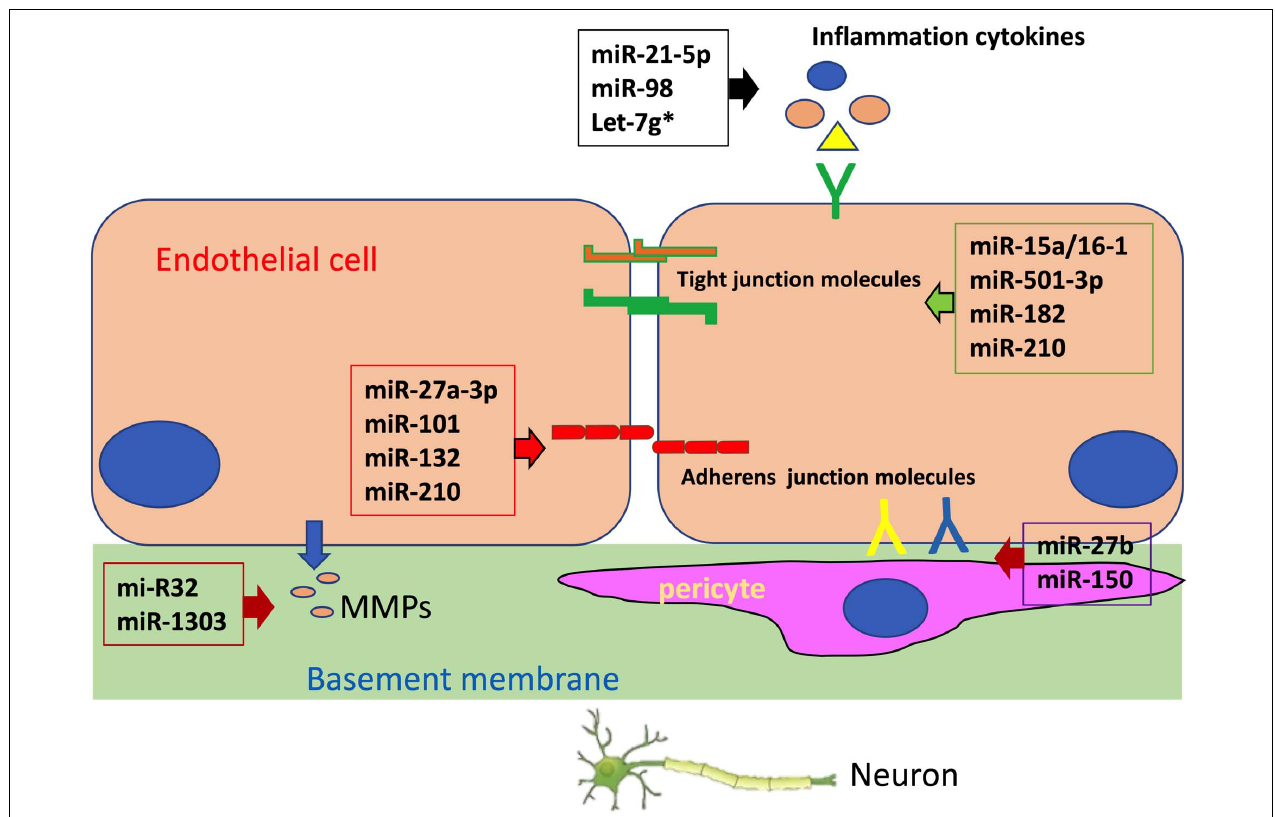
FIGURE 1 | MicroRNAs (miRNAs) regulate blood–brain barrier (BBB) integrity by targeting endothelial tight junction, basement membrane, pericyte coverage, and